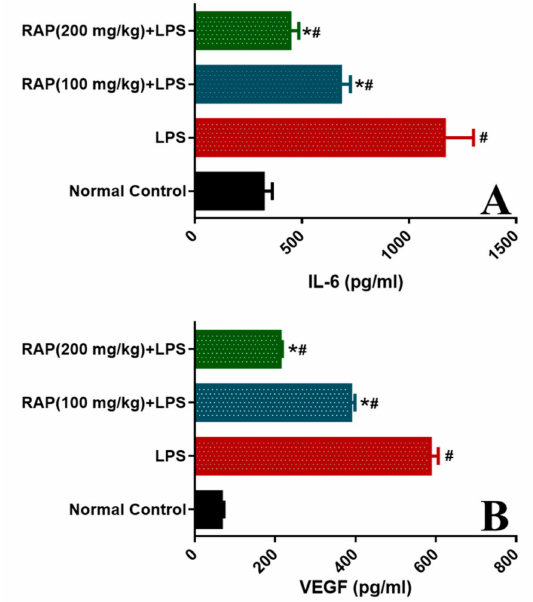
Figure 5. E ff ect of RAP (100 and 200 mg / kg) on pro-inflammatory cytokine levels in the plasma of LPS-induced systemic inflammation ( A ) Interleukin-6 (IL-6), and ( B ) Vascular endothelial growth factor (VEGF); results are mean SEM of seven animals per group. ‘*’ denotes significant di ff erences compared with the normal control group ( p < 0.05); ‘#’ denotes significant di ff erences compared with the LPS group ( p <